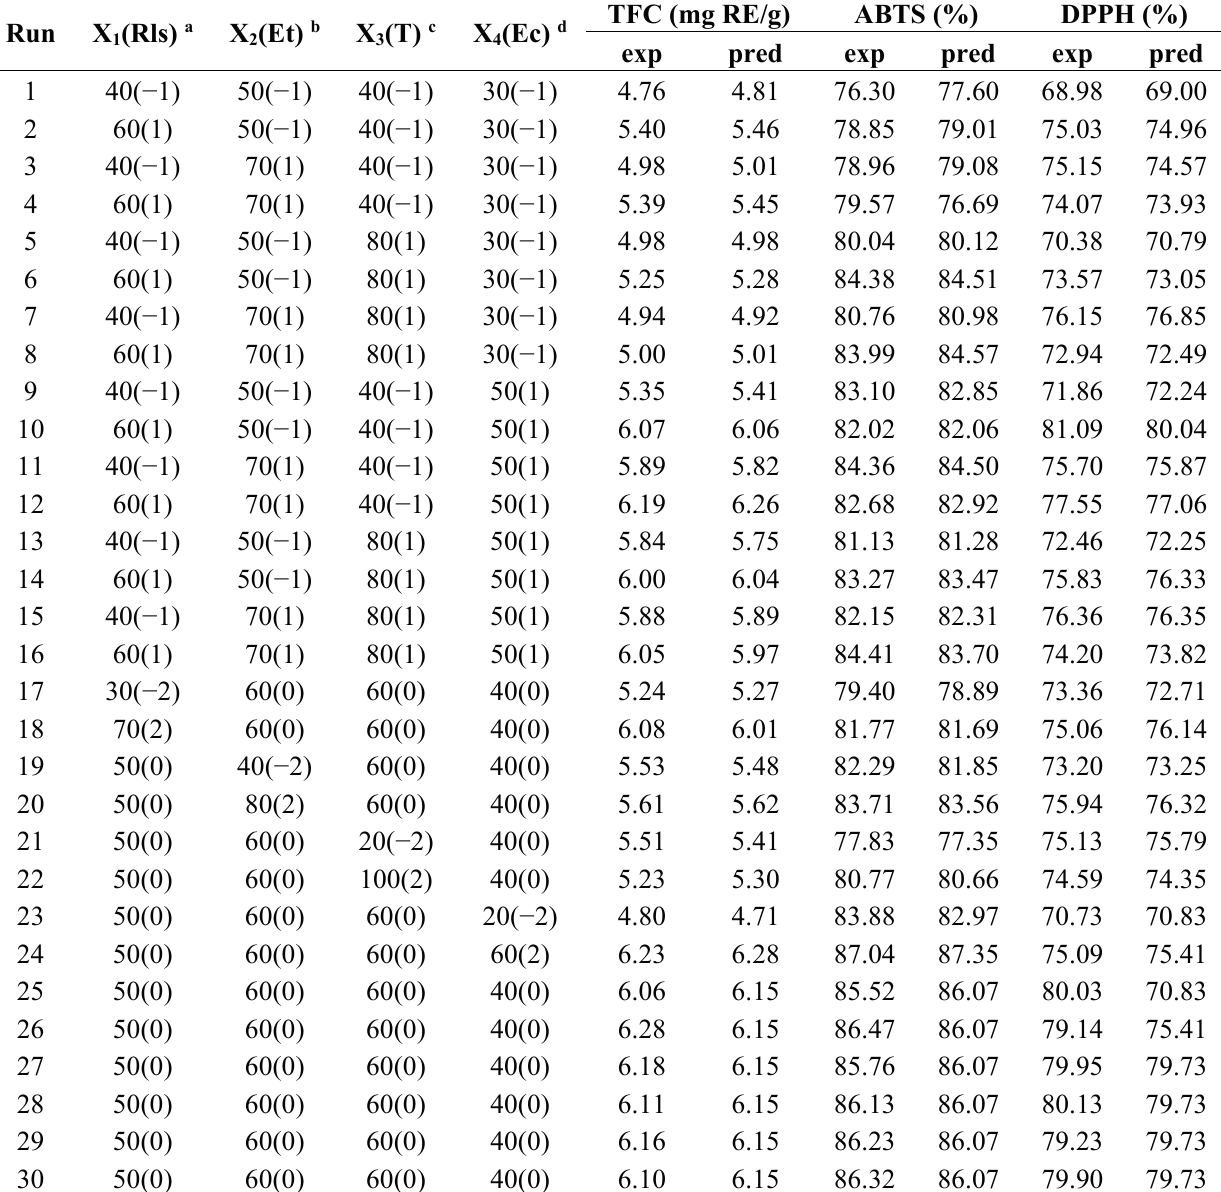
Table 1. Coded and real levels of the operational parameters and experimental and predicted values for different levels of experiment